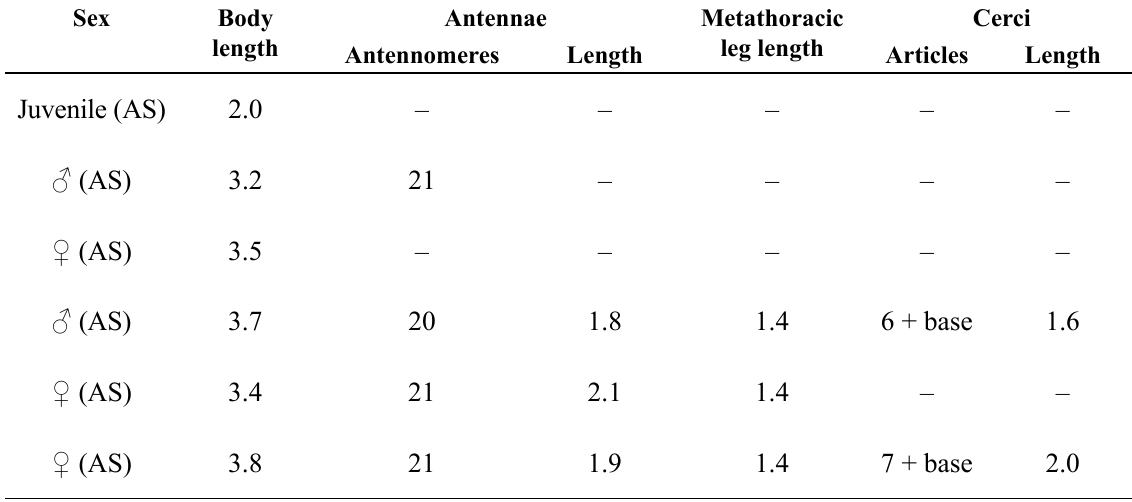
Table 2. Plusiocampa (Plusiocampa) sp. from Franconian Alb caves, length of the body, antennomeres, metathoracic leg and cerci (units in mm), and number of antennomeres and cercal